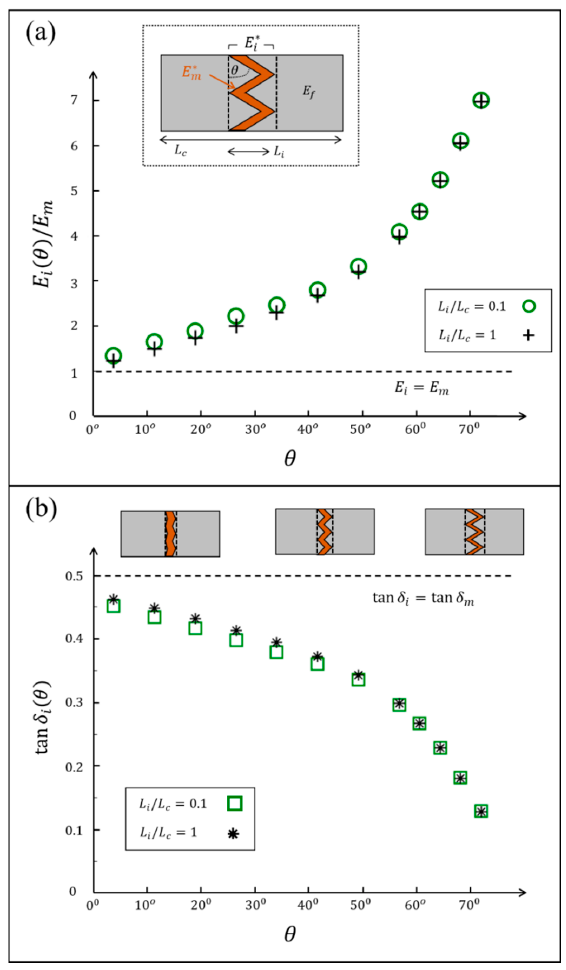
Figure 5. Simulation results for the interfacial dynamic modulus of biocomposites with zigzag- shaped sutural interfaces. ( a ) the modulus magnitude and ( b ) the loss coefficient of the interfacial region for different zigzag angles ( θ ), achieved by back-calculations from far-field DMA testing on the biocomposite ( L i / L c = 0.1), and by direct DMA testing on the interfacial region ( L i / L c =